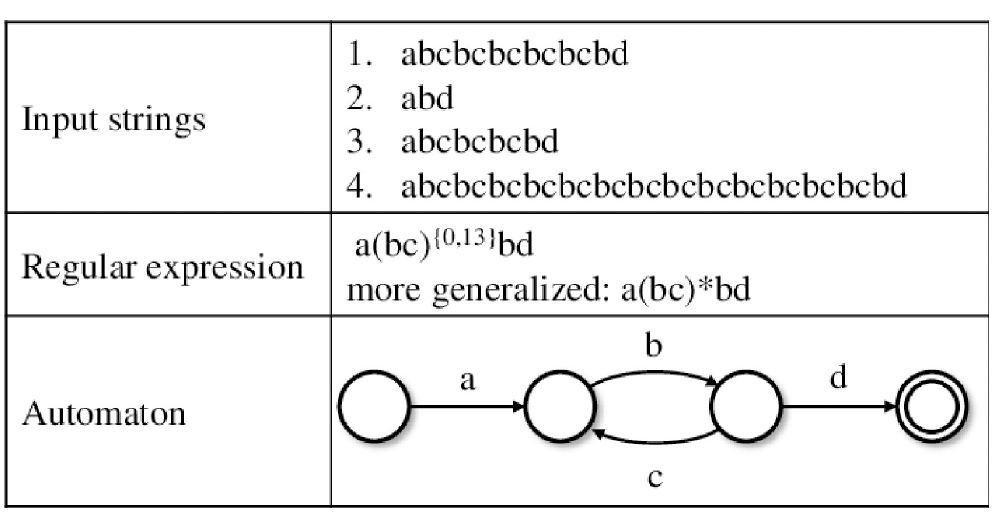
Fig 18. Examples of representations of a given input string set using regex and an automaton.